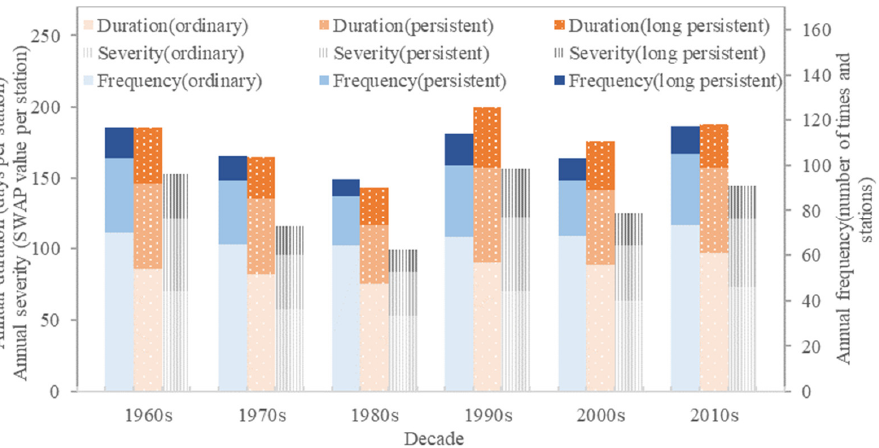
Figure 6. Decadal variation of annual duration, annual severity, and annual frequency of ordinary, persistent, and long persistent drought events.